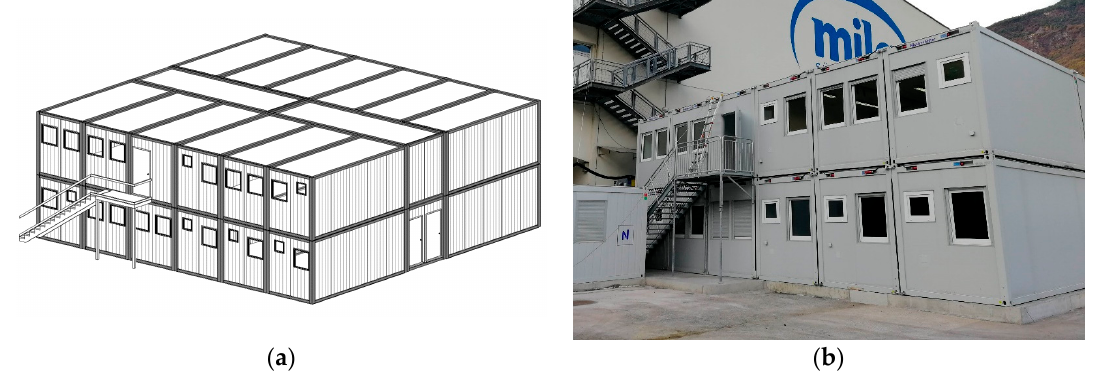
Figure 16. Pilot project: (a) BIM model and (b) Realization.